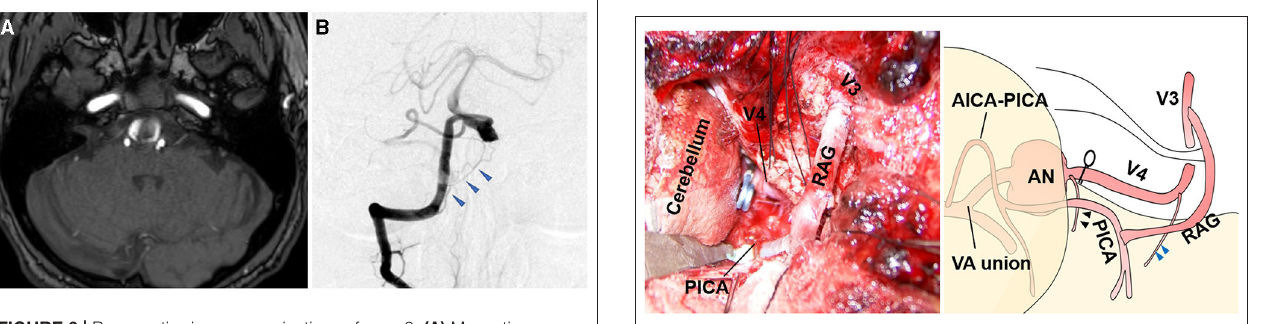
FIGURE 8 | Intraoperative microscopic image and its schematic for case